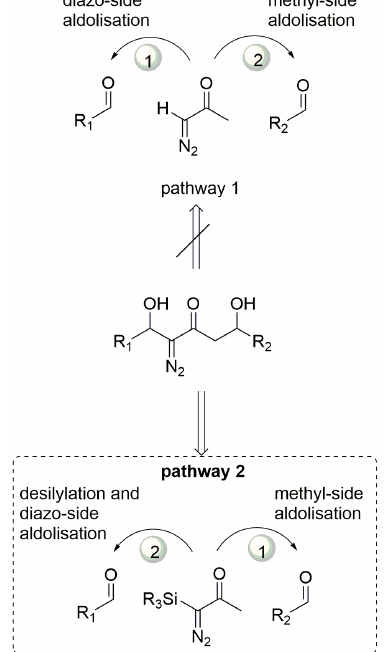
Figure 46 - Substitution of α-hydrogen by silyl group as strategy for the bisaldolization of diazoketone.